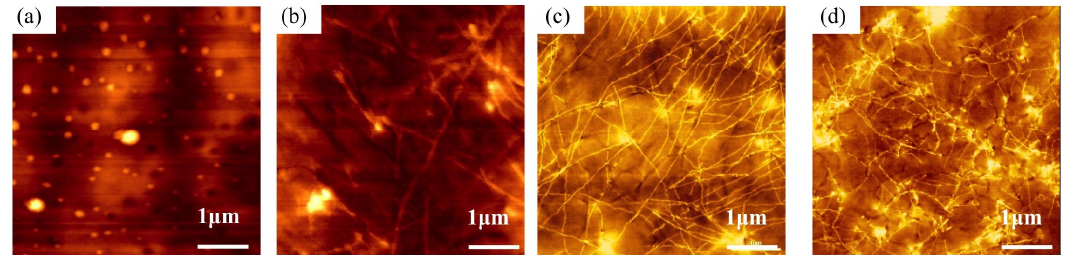
Figure 4. SFM images of P3HT/PMMA nanofiber composite films made from a